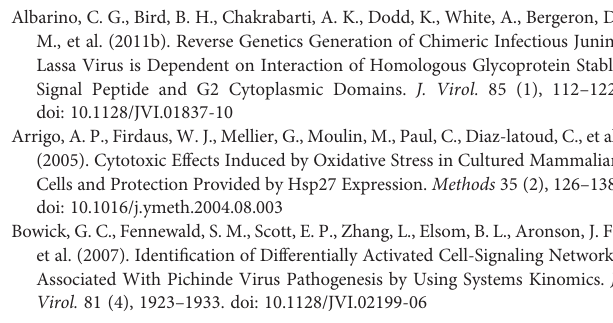
Supplementary Figure 1 | Optimizing infection of HSAEC cells with JUNV XJ13 and CD1, and experimental layout. (A) HSAEC cells in a 96 well plate were infected witheitherJUNVstrainXJ13orstrainCD1fromanMOIof0-34or0-39respectively, 3 wells per MOI. After 24 hours the cells were fi xed in 10% buffered formalin and stained for JUNV NP and analyzed by HCI to calculate the % positive cells. Supplementary Table 1 | All RPPA results. RPPA results for JUNV XJ13 (XJ) and Candid#1 (CD) compared to mock infected cells. Changes highlighted in yellow (decreased phosphorylation) or blue (increased phosphorylation) have at least a 1.2 fold change and a p ≤ 0.05 as measured by a